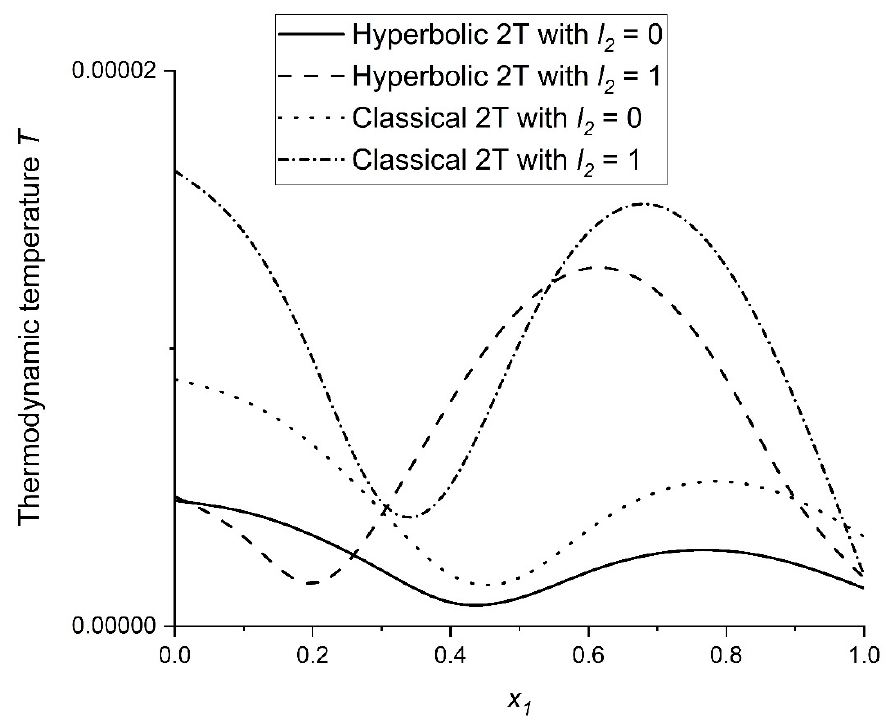
Figure 5. Variations in dimensionless thermodynamic temperature 𝑇 .